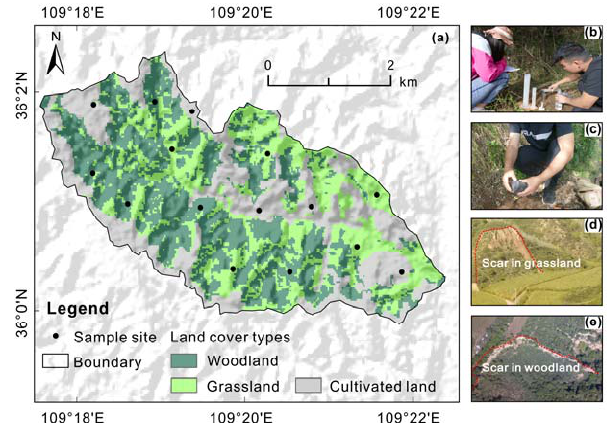
Figure 3. Land cover types and field survey in the study area. ( a ) Land cover and soil sampling site distribution (the grey base map represents the hillshade). ( b , c ) Field experiments. ( d , e ) Landslide scars in grassland and woodland areas.